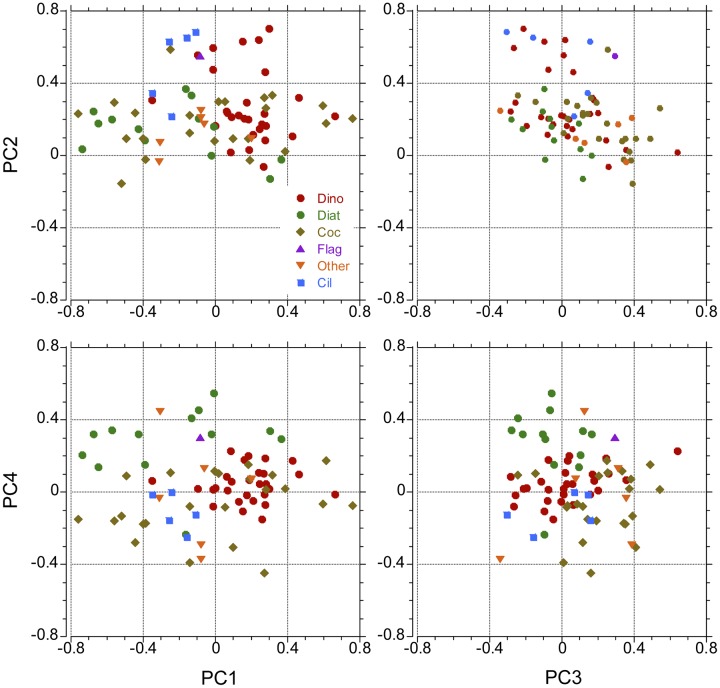
Position of the extremes of the taxa vectors in the space of the principal components.(A) PC1 and PC2. (B) PC3 and PC2. (C) PC1 and PC4. (D) PC3 and PC4. Legend: Dino = Dinoflagellates, Diat = Diatoms, Coc = Coccolithophores, Flag = “Unidentified nanoflagellates (3–20 μm)”, Other = Other taxa, Cil = Ciliates.